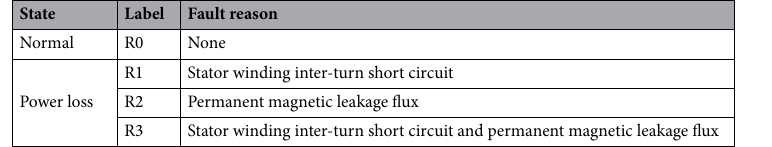
Table 1. The fault reasons of